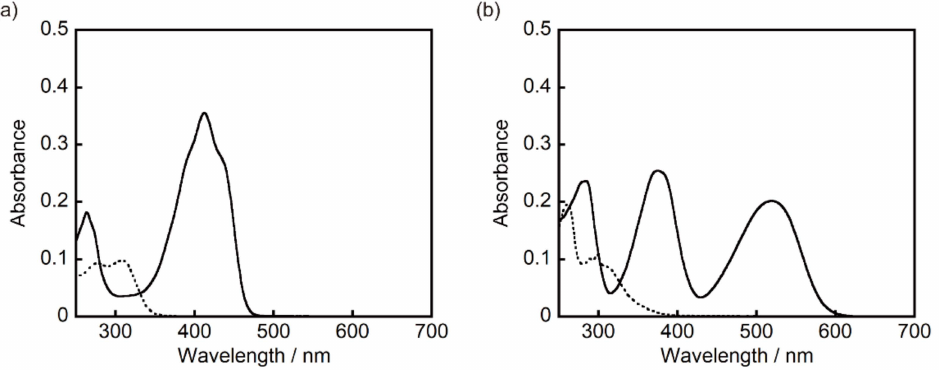
Figure 1. Absorption spectra of 1 ( a ) and 2 ( b ) in ethyl acetate (2.0 × 10 − 5 M). Dotted lines: open-ring isomers 1a and 2a , solid lines: photostationary states under irradiation with 313 nm